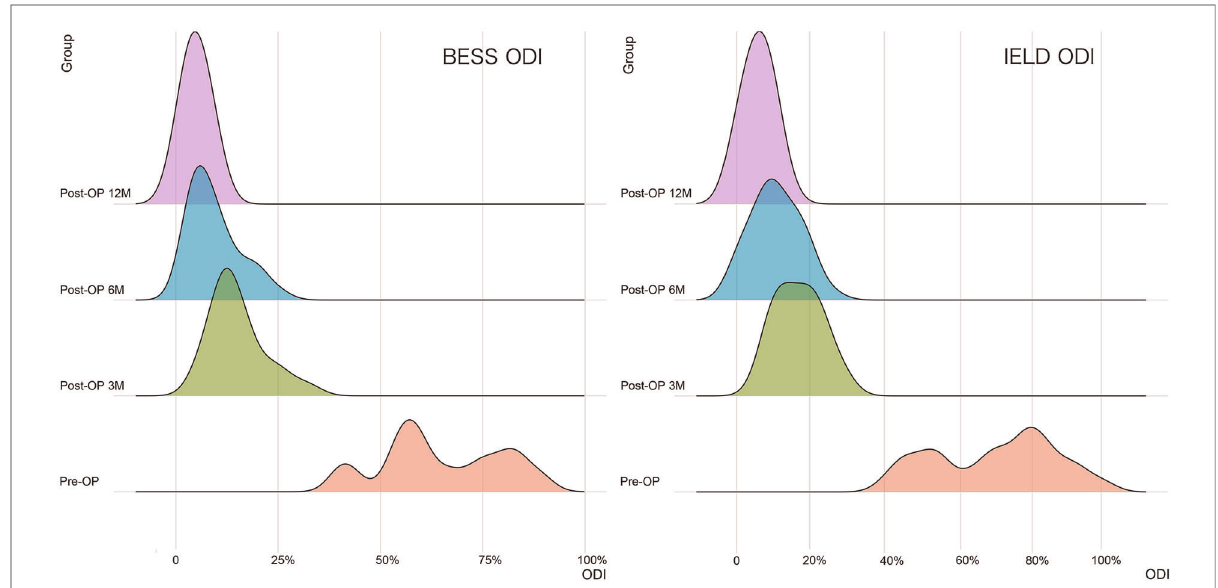
FIGURE 5 In the two groups, signi fi cant differences in postoperative ODI were noted at each time point ( P <0.01), and the ODI decreased signi fi cantly with